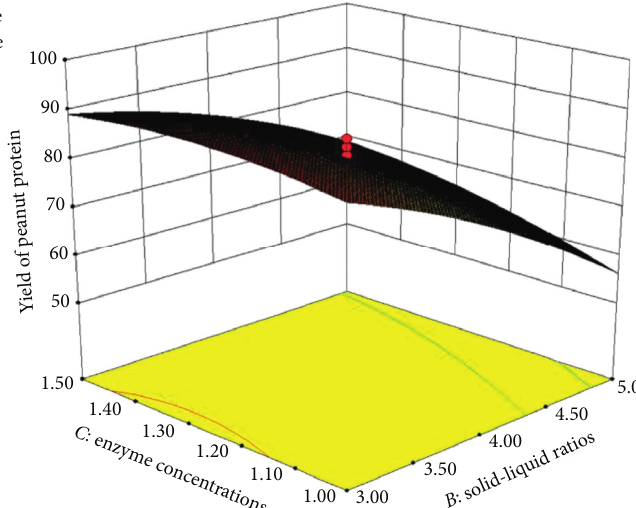
Figure 6: Effect of different solid-liquid ratios and enzyme concentrations on the yield of peanut